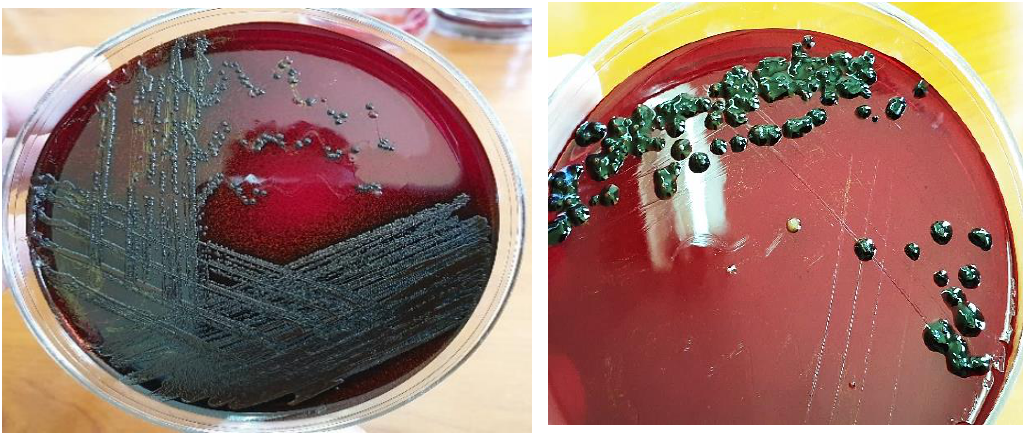
Figure 2 . Biofilm feature of A. hydrophila on modified Congo red